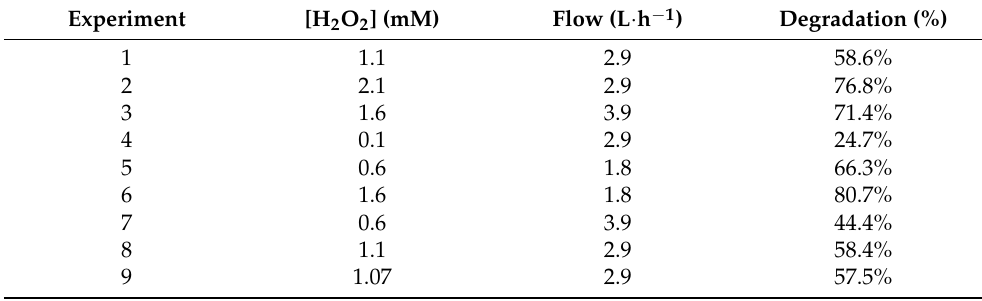
Table 1. Experimental points employed for the generation of a surface response based on Doehlert matrices. The hydrogen peroxide concentration and flow rate for each experiment are given, together with the percentage of removal of acetaminophen reached when 4 L of solution were flown through the reactor.